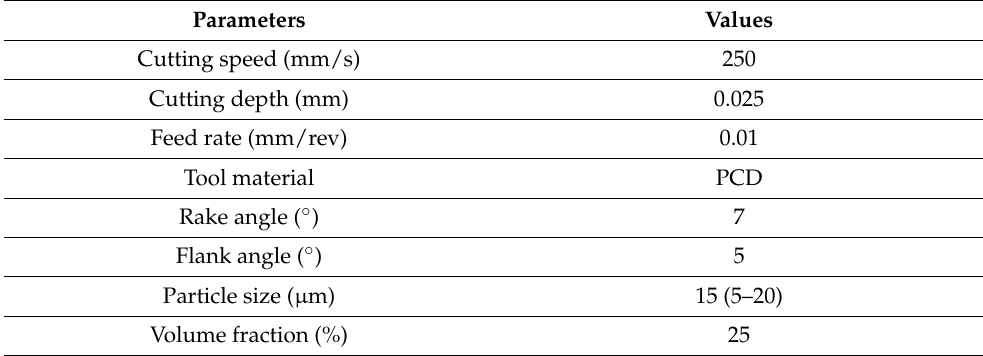
Table 1. Machining parameters and tool specifications.